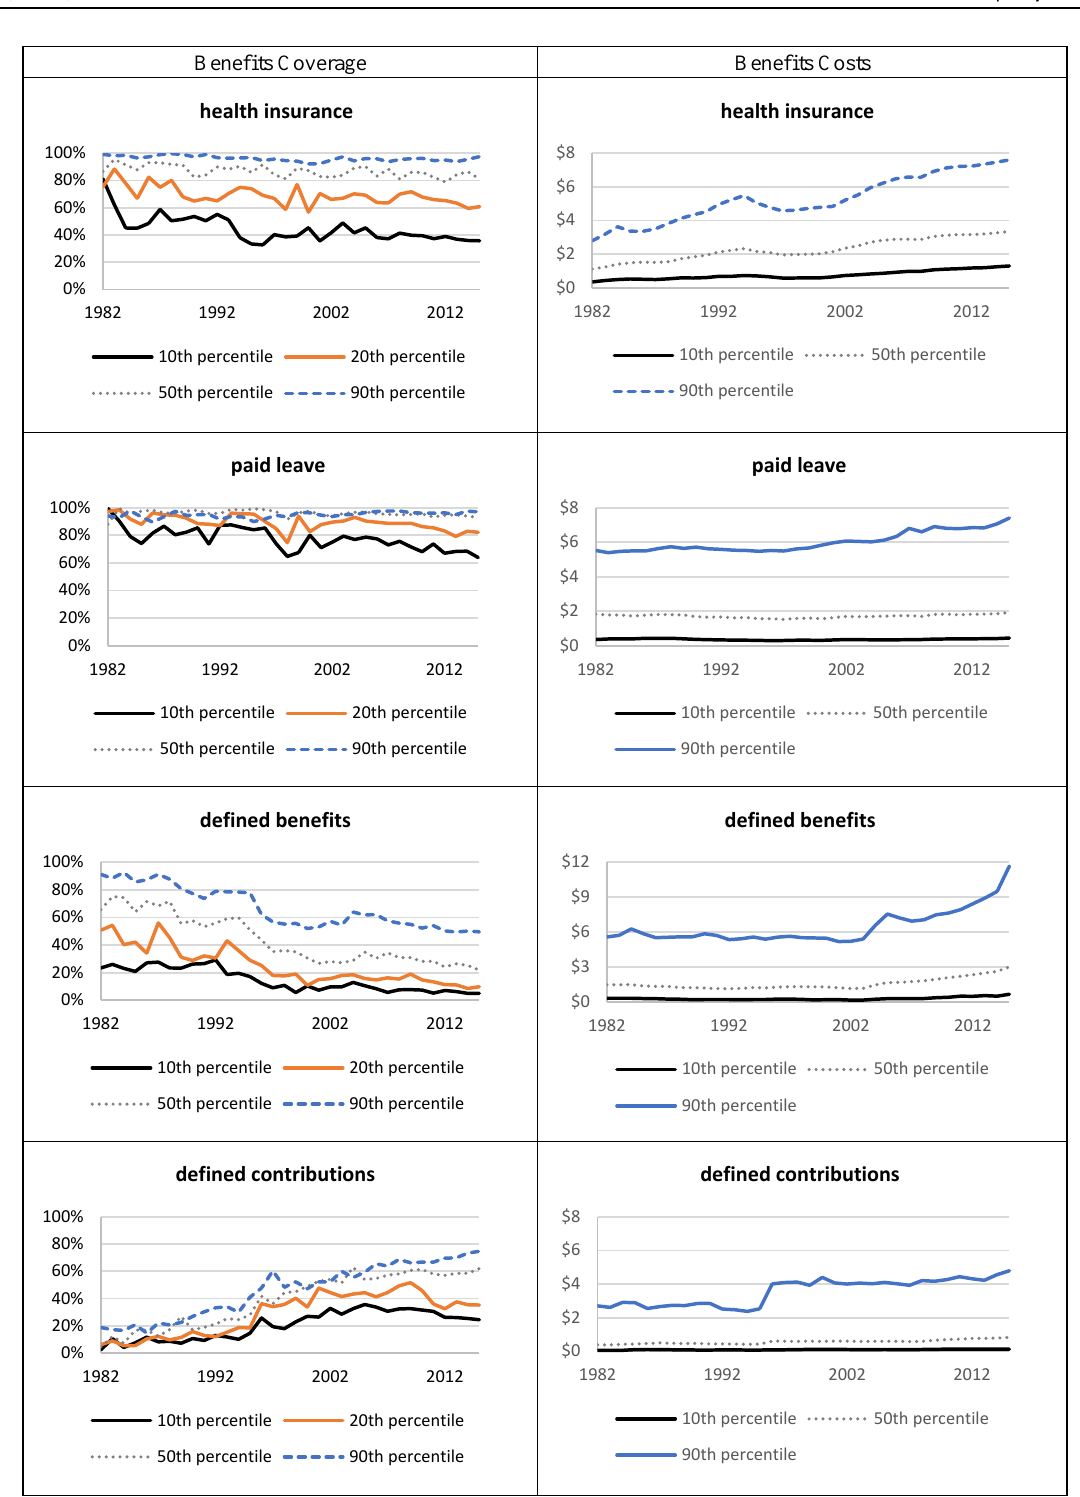
Figure 9: Benefits coverage (fraction of jobs with positive employer costs) according to wage percentiles and benefits costs (for covered workers). Note: Private industry (and state and local government sector) wage and salary workers aged 18 to 65 who worked at least 20 hours per week and 26 weeks per year. sociological science |